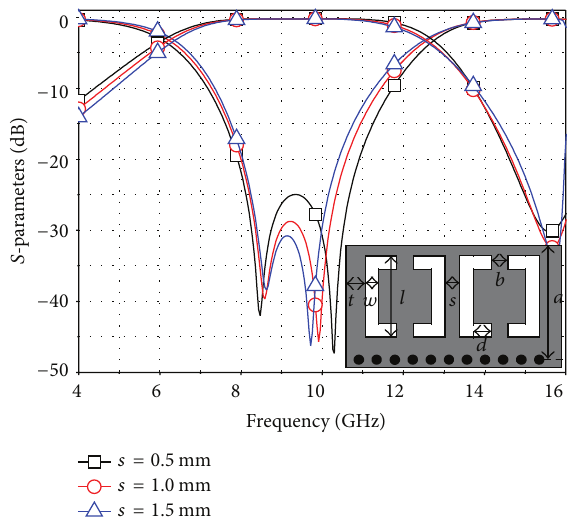
Figure 6: Simulated results of intercoupling between two HMSIW- DGS cells for varied “ s. ” Other geometrical parameters are 𝑎 = 7 mm, 𝑡 = 1 mm, 𝑙 = 5 mm, 𝑤 = 0.5 mm, 𝑑 = 0.75 mm, and 𝑏 = 0.5